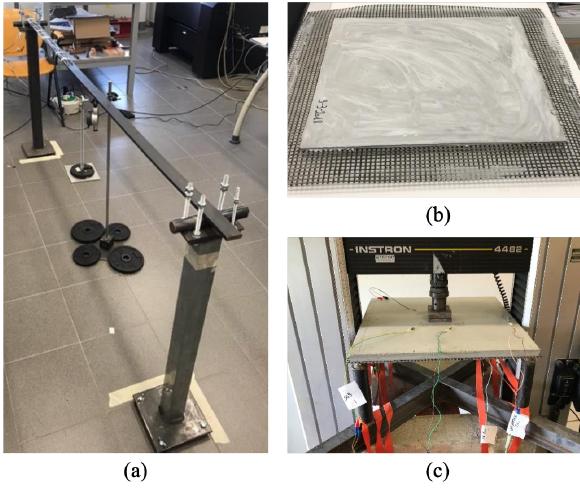
Figure 4: Three-point bending test on a simply supported steel beam (a). The realized FRP concrete square plate (b) and five-point bending test setup (c)